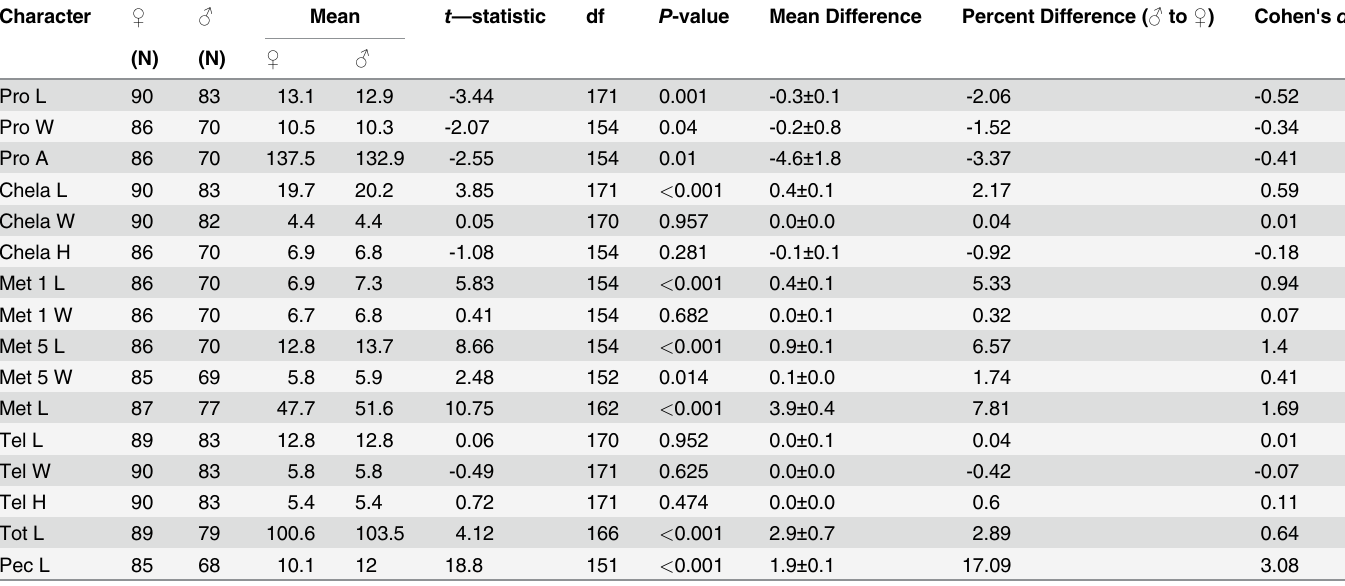
Table 1. Comparison of morphological characters of adult female and male Hadrurus arizonensis .